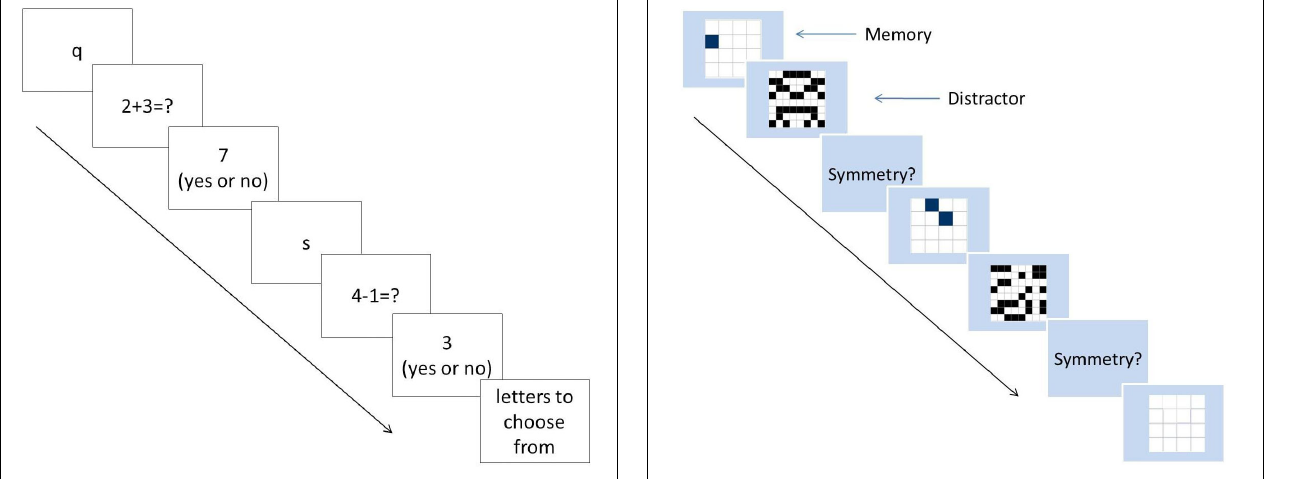
FIGURE 1 | Sample process of operation span task (OSpan).